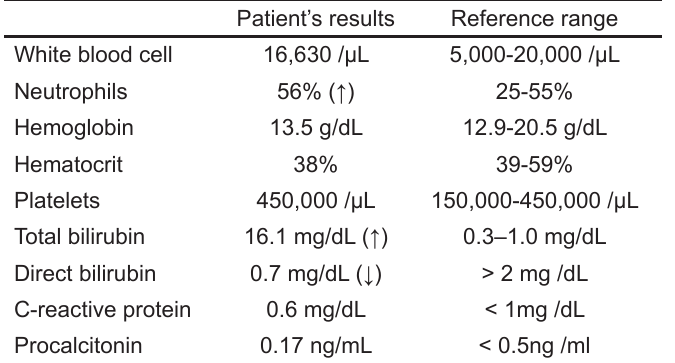
Table 1. Laboratory test results for neonate with suppurative parotitis.